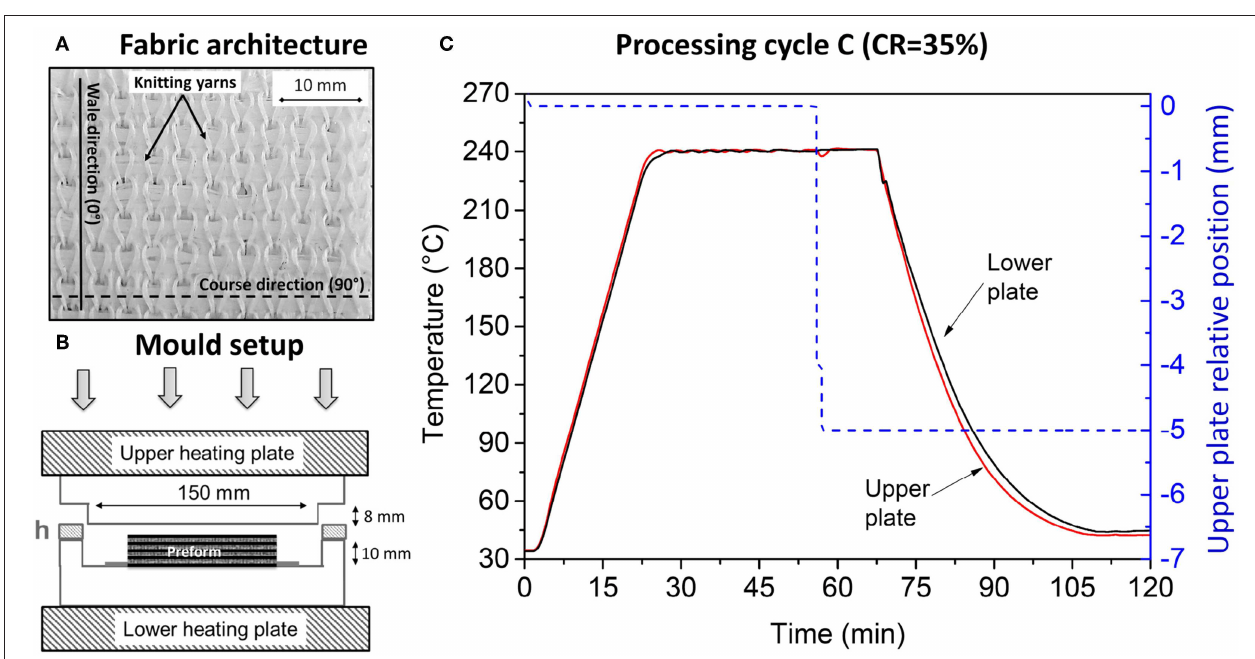
FIGURE 1 | Biaxial weft-knitted fabric and manufacturing process. (A) Arrangement of yarns of the biaxial weft-knitted fabric (top-left). (B) Schematic of the mold set-up (bottom-left). (C) Temperature and mold plate displacement cycles during the compression molding at cycle C (CR = 35%) (right).